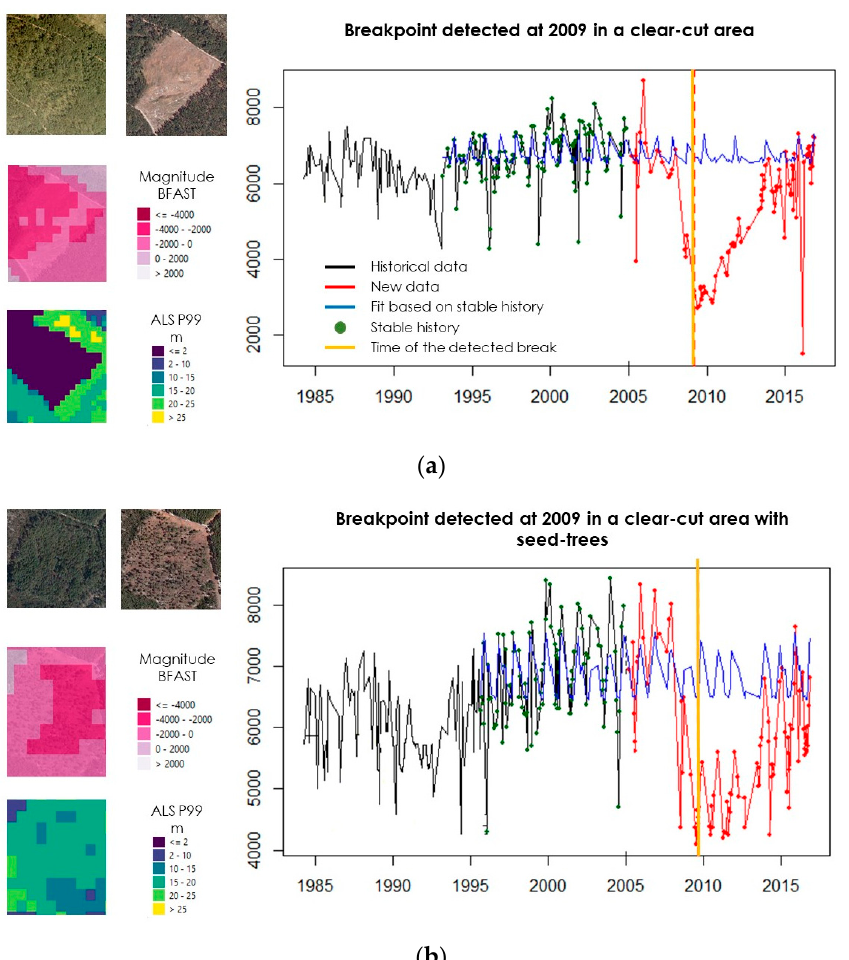
Figure 8. NBR BFAST results and ALS P99 metric differences for two pixels in which a breakpoint is detected in 2009. ( a ) Represents a pixel within a clear-cutting area while ( b ) is a cutting with-seed trees pixel.